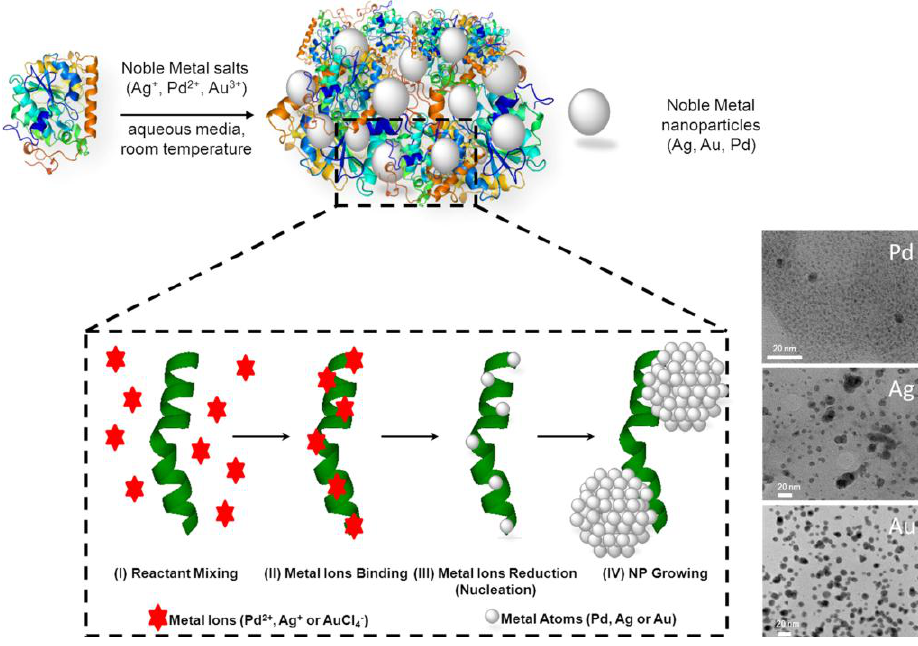
Figure 9. Preparation of metal bionanohybrids.